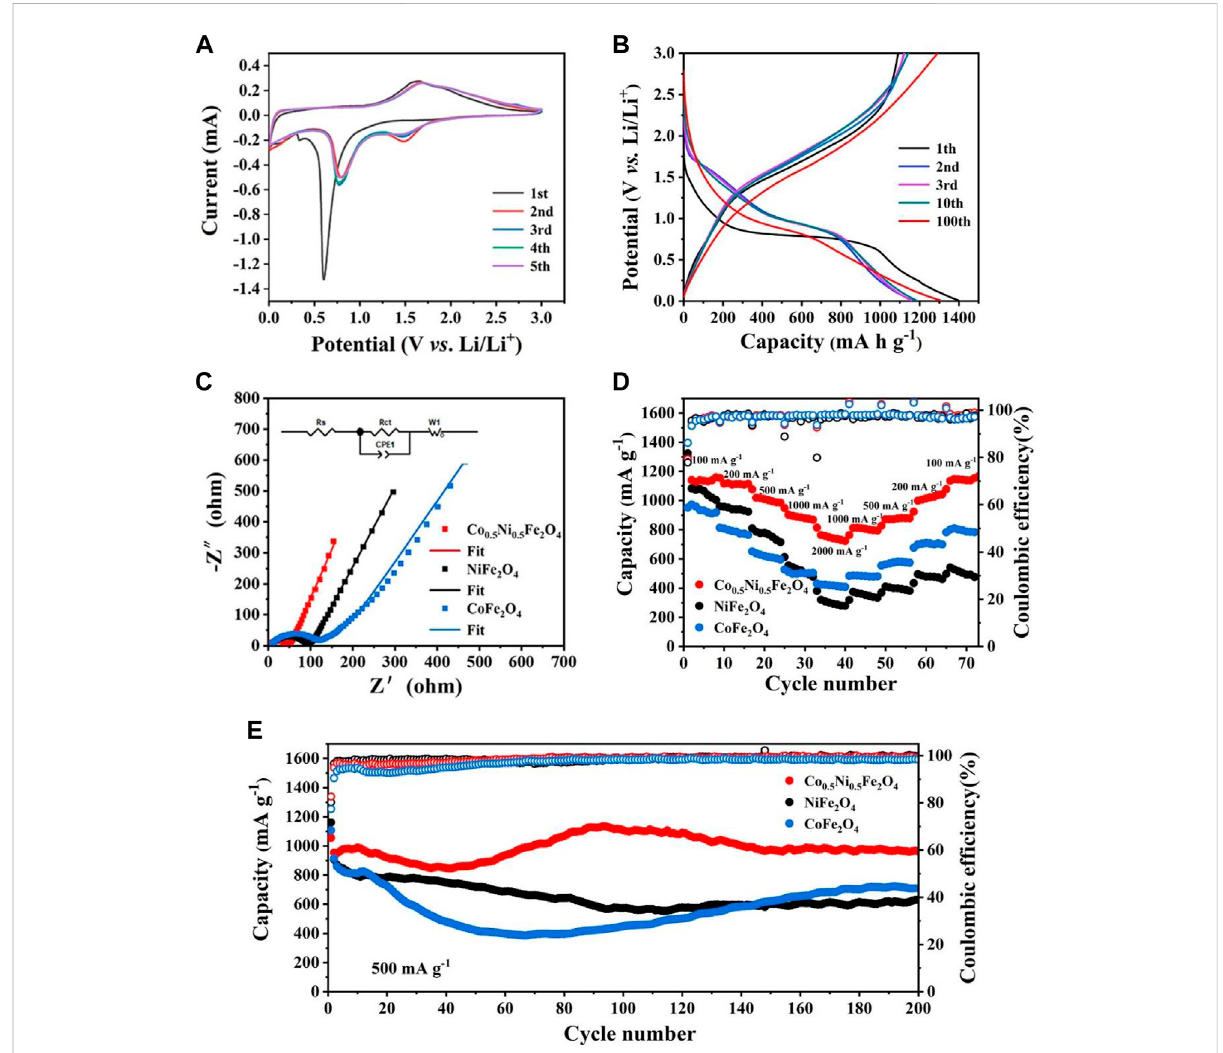
FIGURE 4 (A) CV curves ofCo 0.5 Ni 0.5 Fe 2 O 4 inthe fi rst fi ve cycles at0.1 mV s − 1 . (B) Discharge-charge curvesof Co 0.5 Ni 0.5 Fe 2 O 4 at 200 mA g − 1 . (C) Nyquist plots of the